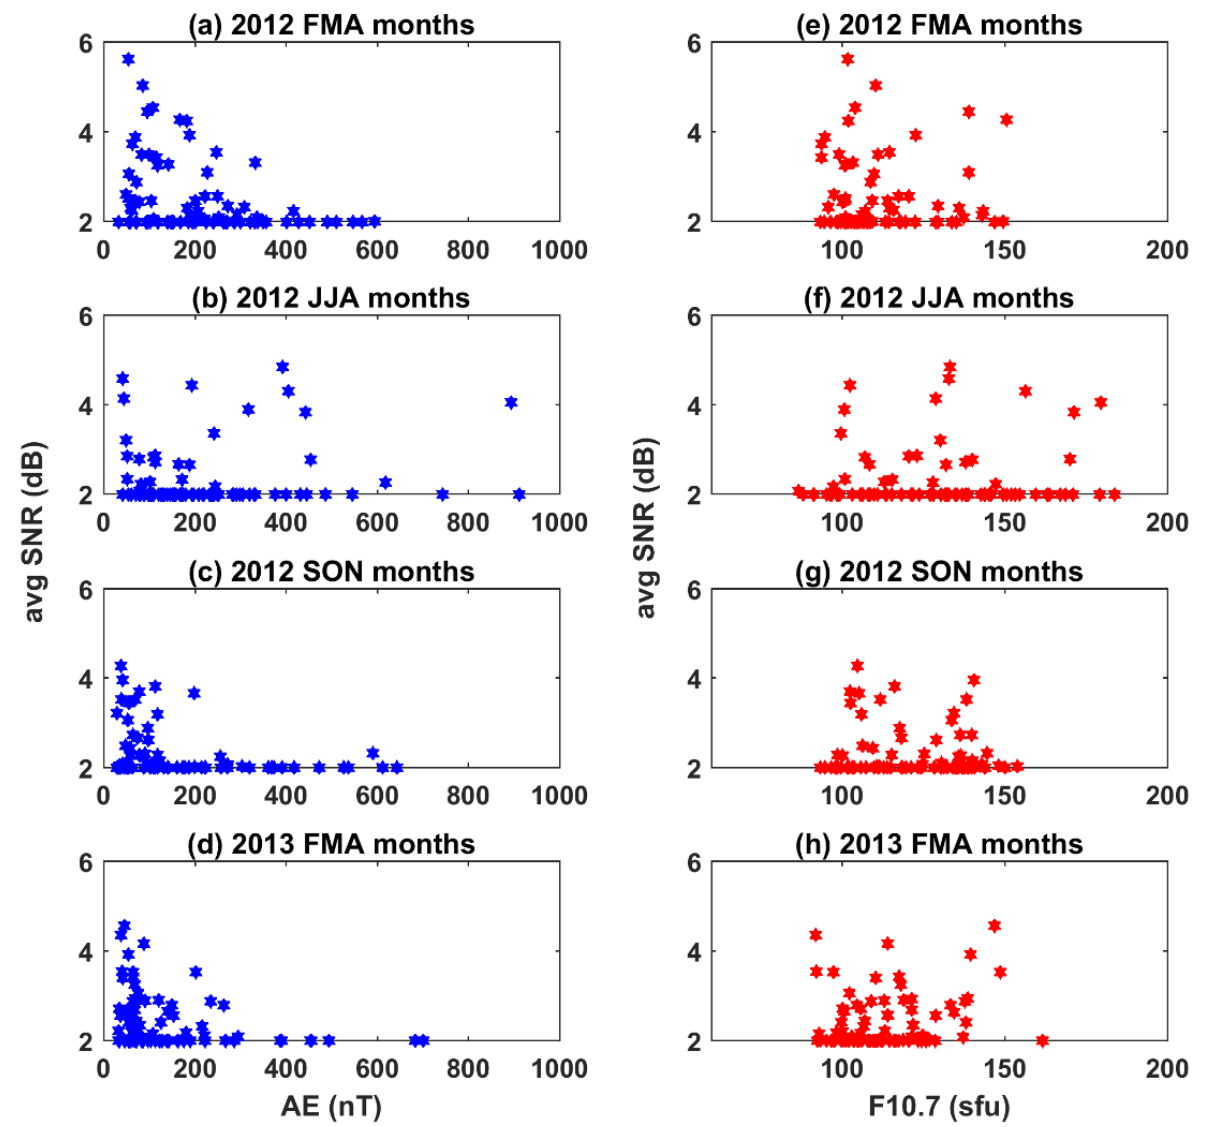
Figure 7. ( a – d ) scatter plot analysis of AE and SNR (nocturnal average, 300 km) for FMA 2012,